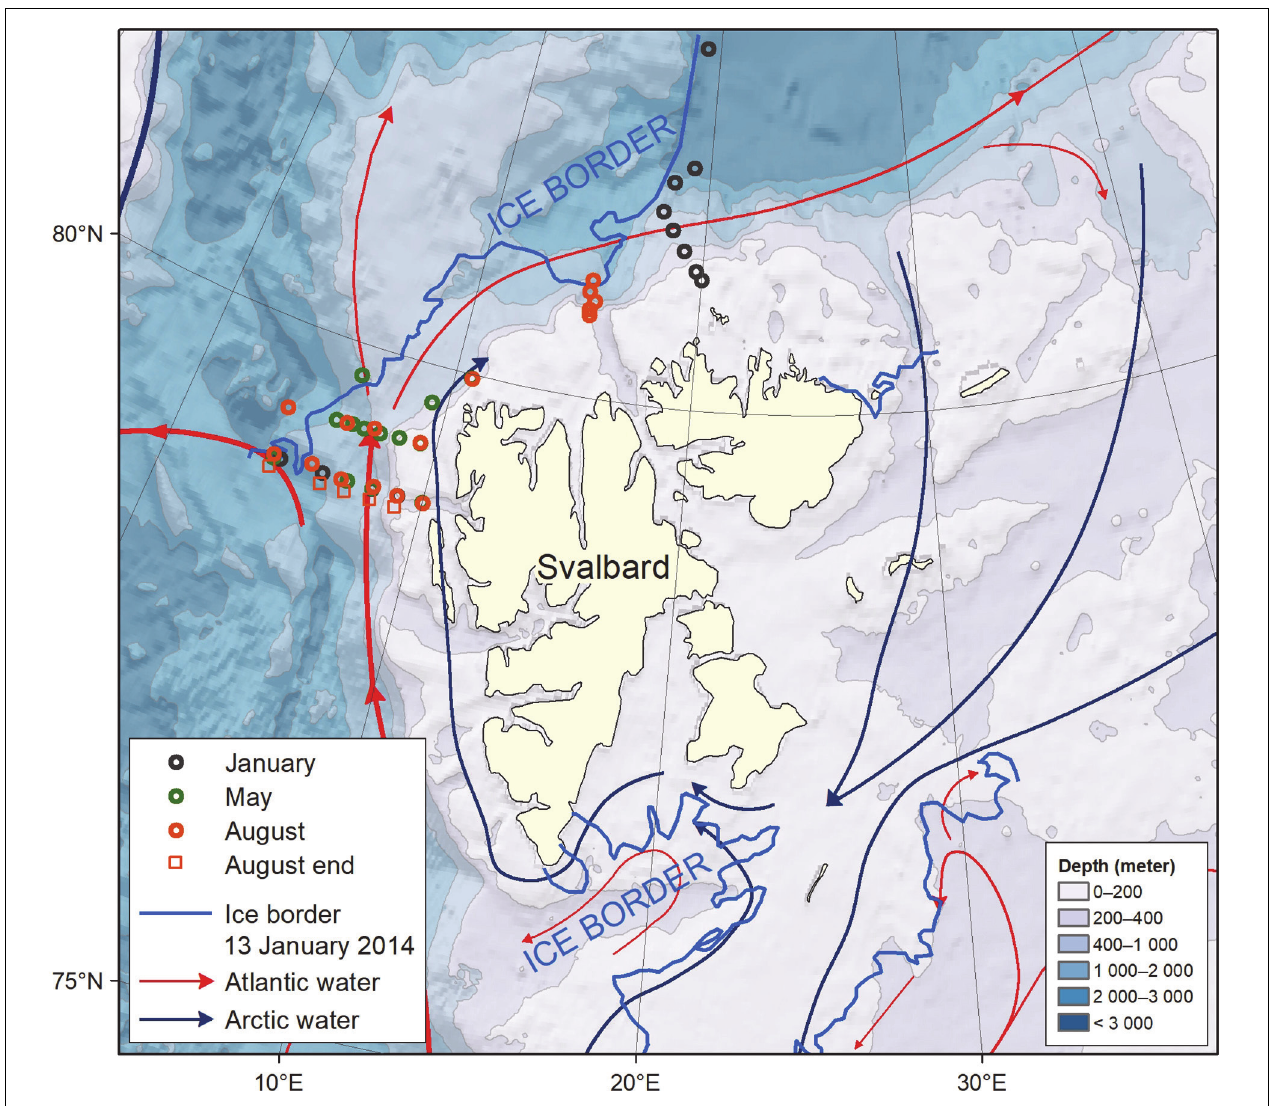
FIGURE 1 | Map of the study area with station locations of the four different cruises. Shown are the major surface currents (Arctic in blue and the Atlantic water in red), and ice edge at 13th January 2014 (marked blue line).